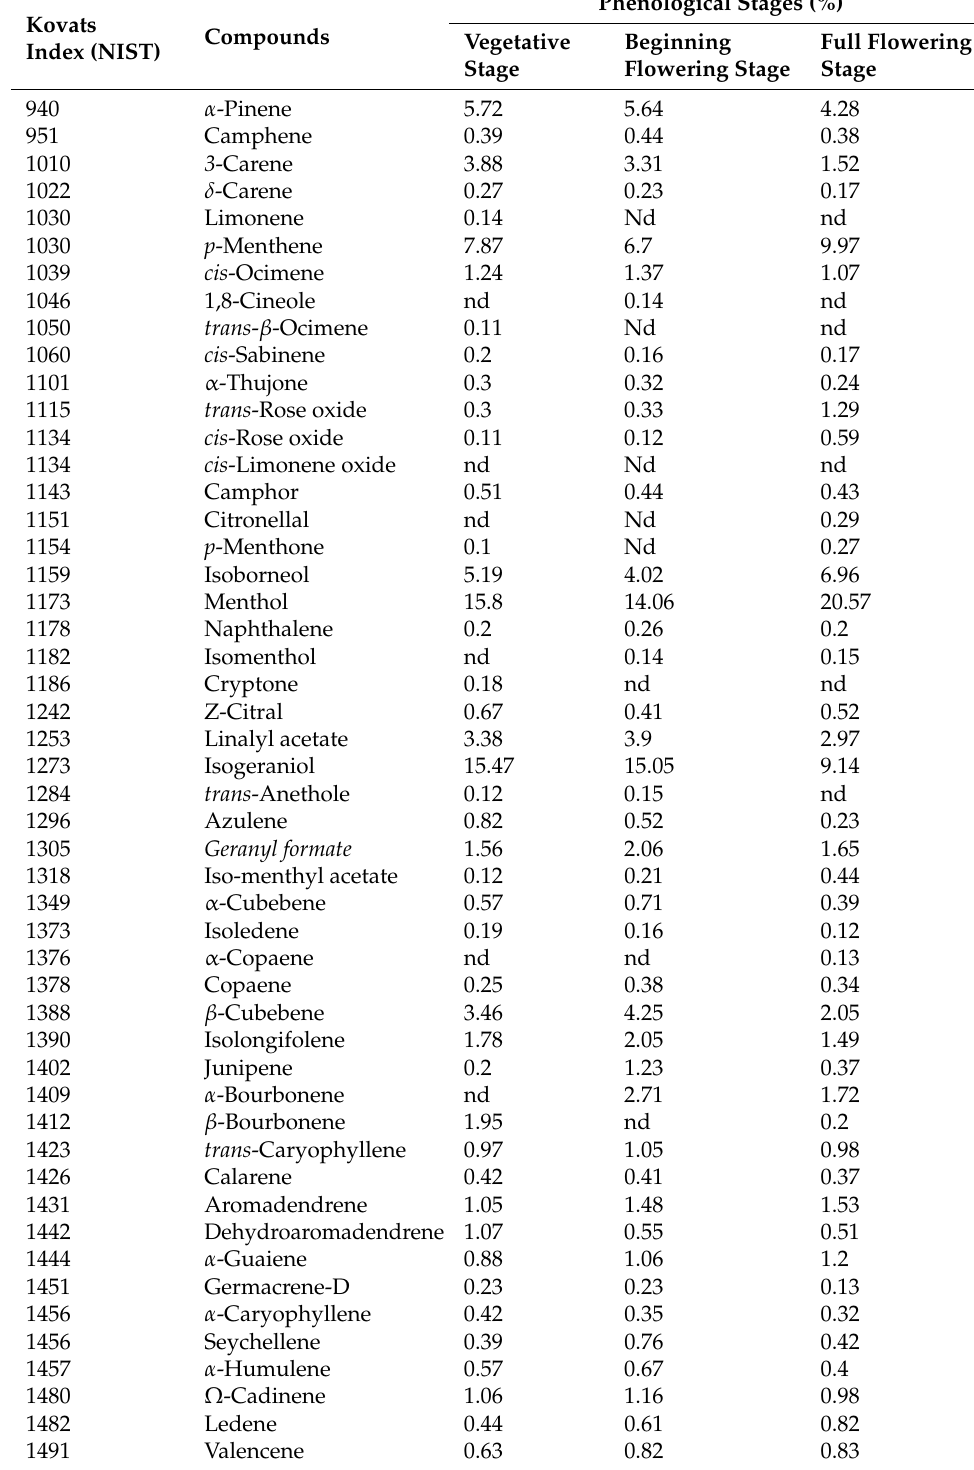
Table 1. Composition of PGEOs obtained by GC-MS analysis from plant material collected at different phenological stages, namely vegetative stage, beginning flowering stage, and full flowering stage. The values represented the average of 3